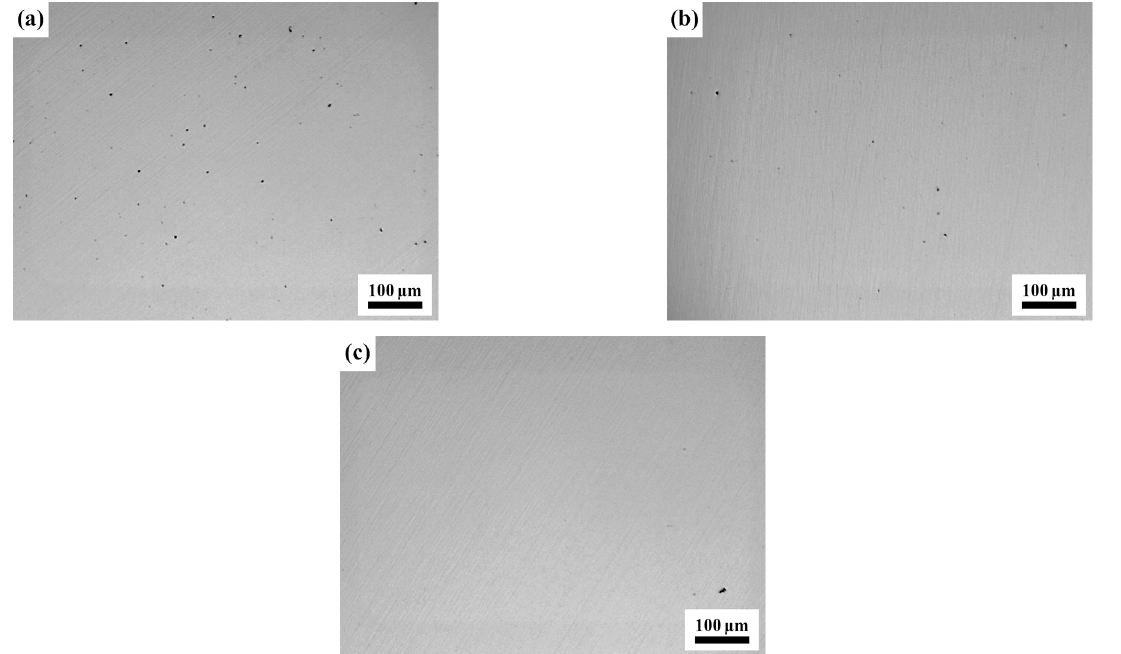
Figure 2. OM images of the as-HIPed P/M FGH97 superalloys, ( a ) Ni1#, ( b ) Ni2#, and ( c ) Ni3#.